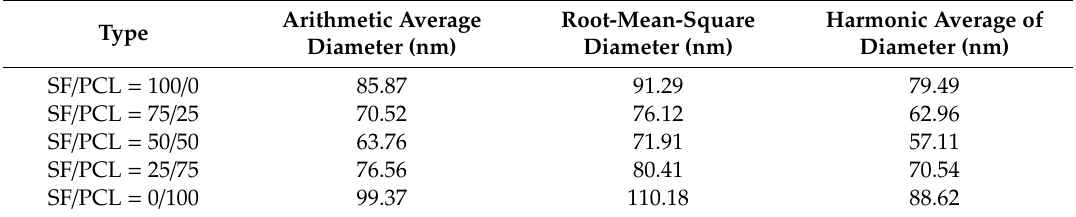
Figure 4. Field emission (FE)-SEM micrographs of the five different types of electrospun membranes: ( a ) W SF :W PCL = 100:0, ( b ) W SF :W PCL = 75:25, ( c ) W SF :W PCL = 50:50, ( d ) W SF :W PCL = 25:75, and ( e ) W SF :W PCL = 0:100; and ( f ) average diameter of nanofibers. Table 2. Nanofiber diameters in membranes.